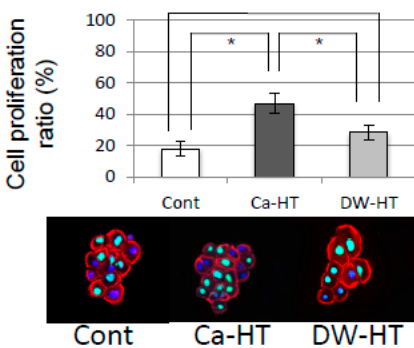
Figure 10. Cell proliferation assay. The percentages of OECs proliferating on Ca-HT, DW-HT and Cont were significantly different among the groups. Bars represent the mean ± SD. * P < 0.05.